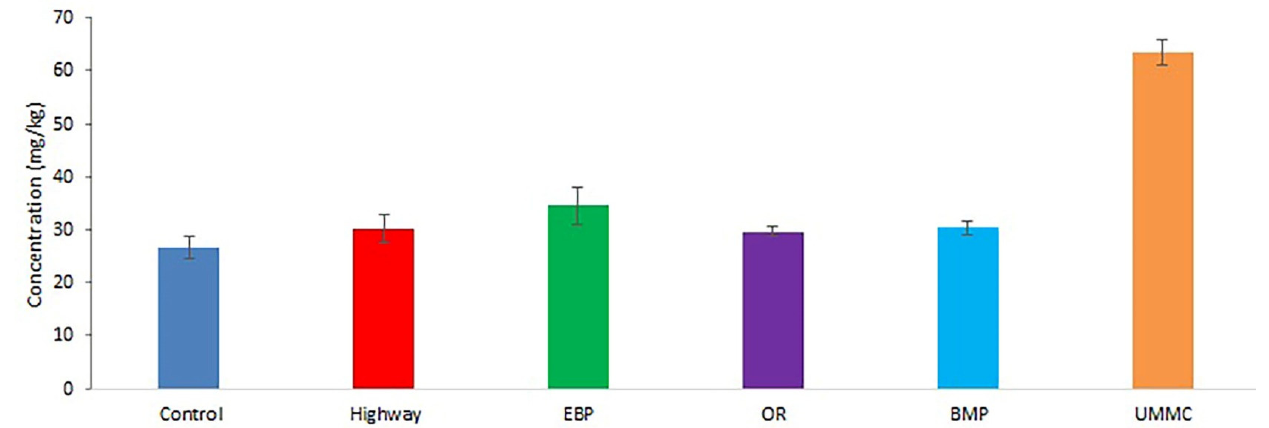
Figure 3. Mn concentration (mean ± 95% confidence interval) in coltsfoot from studied areas. The Zn content in coltsfoot ranged from 21 to 44 mg kg − 1 (Figure 4). Similar Zn